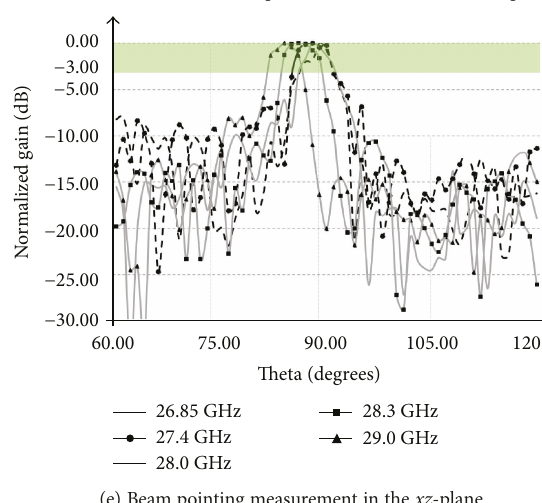
Figure 7: Characterization of the omnidirectional ring-based SWAA: simulation (dashed lines); measurements (continuous